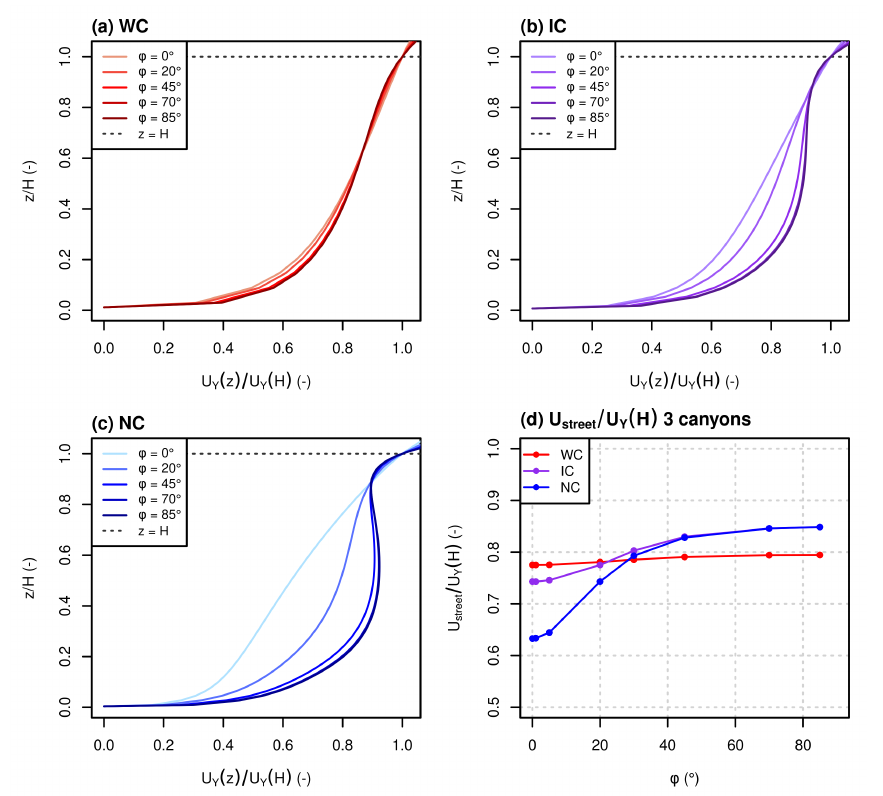
Figure 3. Comparison of the Code_Saturne vertical profile of wind speed in the street direction ( U Y ( z ) ) normalized by the wind speed at the roof level ( U H , ϕ ) for different wind angle ( ϕ ) and for ( a ) WC, ( b ) IC and ( c ) NC. ( d ) Comparison of the Code_Saturne average wind speed in the street ( U street ) normalized by U H , ϕ depending on ϕ and for the three